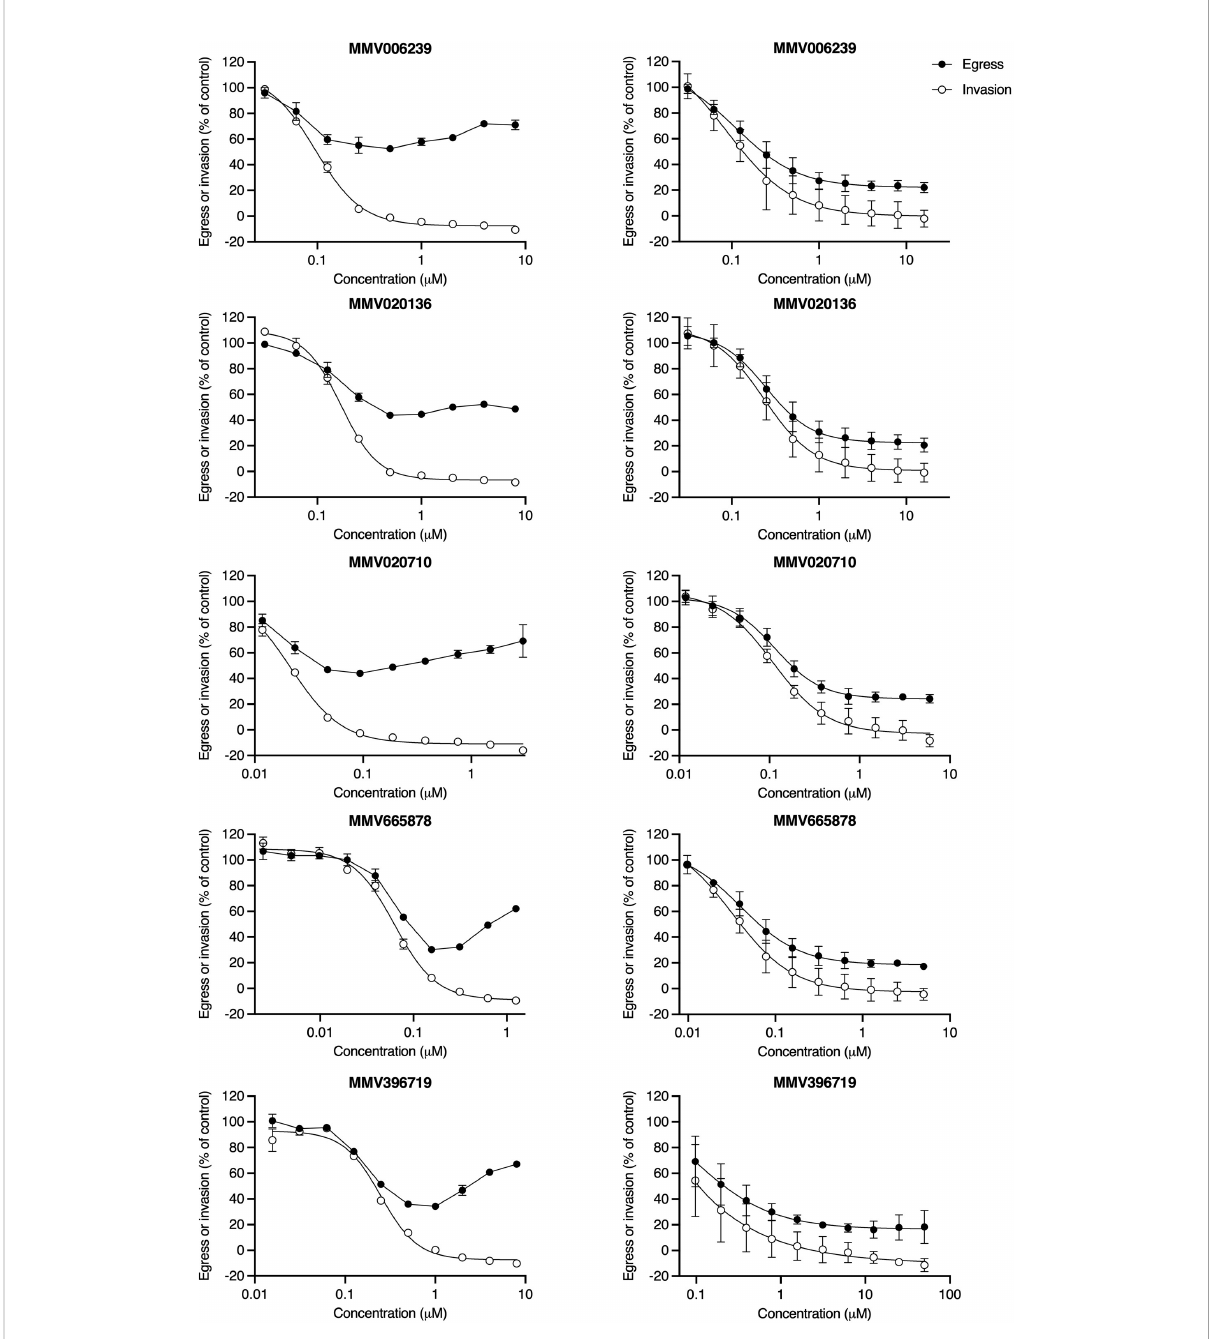
FIGURE 2 Pf ATP4 inhibitors induce cell rupture when administered to cultures of schizonts with a wide age range but prevent the rupture of synchronous late-stage schizonts. In the “ nanoluciferase egress and invasion assay ” , 3D7_Hyp1-Nluc schizonts were exposed to a 2-fold dilution series of Pf ATP4 inhibitors. Egress was quanti fi ed after 4 h by measuring the bioluminescent signal intensity of nanoluciferase released into the extracellular medium. Drugs were then removed and unruptured schizonts were lysed by sorbitol treatment. Invasion was quanti fi ed 24 h later by chemically lysing the resultant trophozoite cultures and measuring the total nanoluciferase signal of the lysate. When the “ nanoluciferase egress and invasion assay ” was conducted using schizonts with a wide age range (~35-42hpi; left-hand column), high concentrations of Pf ATP4 inhibitors did not inhibit nanoluciferase release but did reduce subsequent invasion. For each compound, data obtained in a single experiment are shown as an illustrative example of those obtained in at least two independent experiments (Supplementary Figure 5). Points and error bars represent the mean ± SD of technical duplicates or triplicates. When this assay was conducted using late-stage schizonts with a narrow age range (40-42 hpi; right-hand column), Pf ATP4 inhibitors caused concentration-dependent inhibition of egress and invasion and did not block invasion independently of egress at any concentration. Points and error bars represent the mean ± SD of three biological replicates, each consisting of technical duplicates. All values have been normalised to the DMSO vehicle